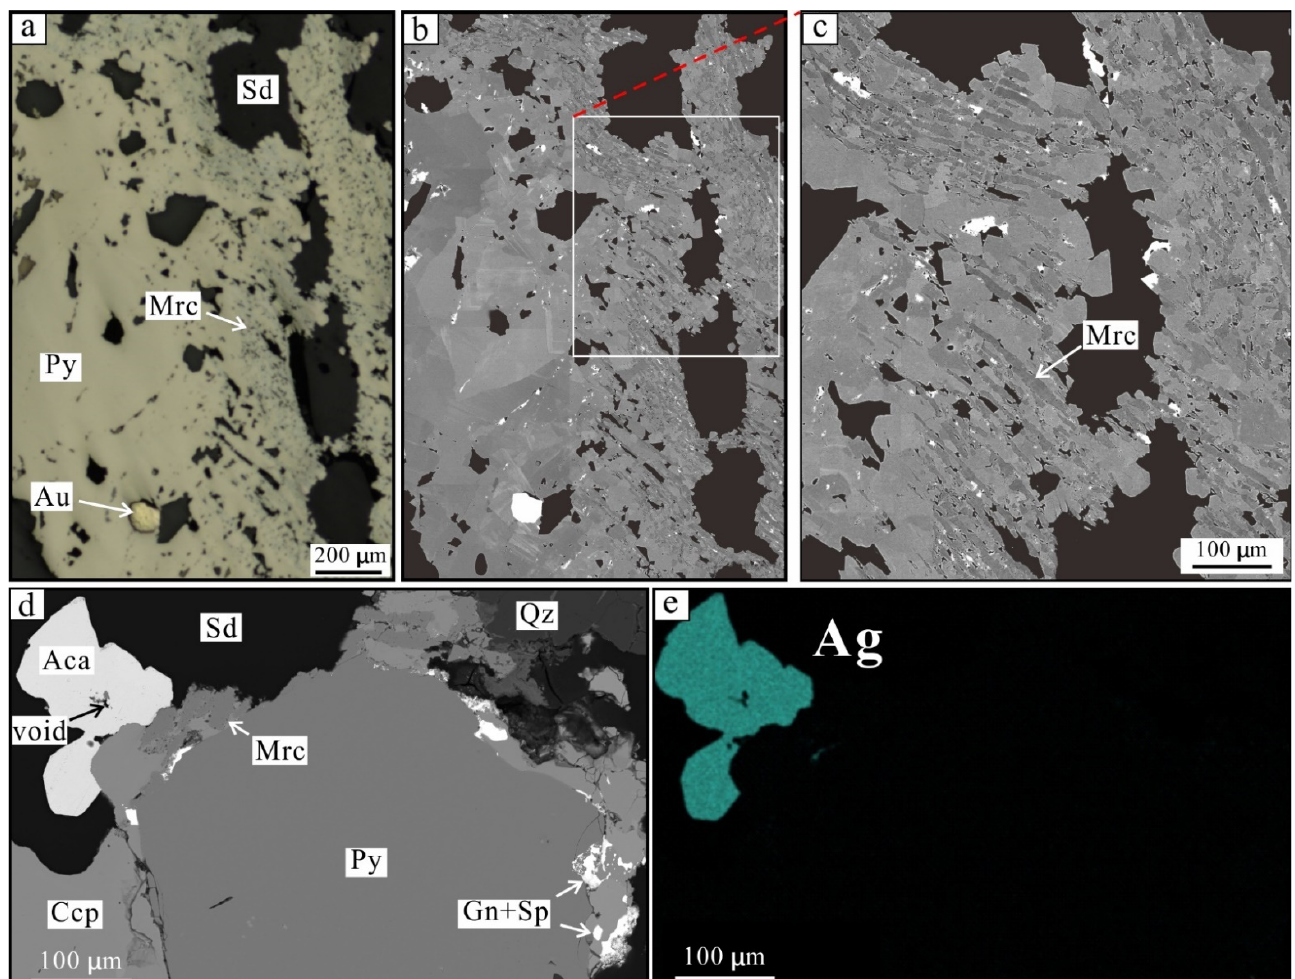
Figure 5. ( a ) Reflected-light photograph showing the relationships among pyrite, marcasite, and gold. ( b ) The corresponding SEM-BSE image of ( a ). ( c ) SEM-BSE image showing that the marcasite grains display slightly weaker BSE intensity than those of pyrite. Marcasite grains are characterized by thin strips and directional arrangement. ( d ) SEM-BSE image of the primary assemblages of pyrite and chalcopyrite and the secondary assemblages of acanthite, marcasite, and siderite, with minor galena and sphalerite. ( e ) EDS map showing the distribution of Ag. Abbreviations are the same as those in Figure 3. Gn: galena; Ag: silver.